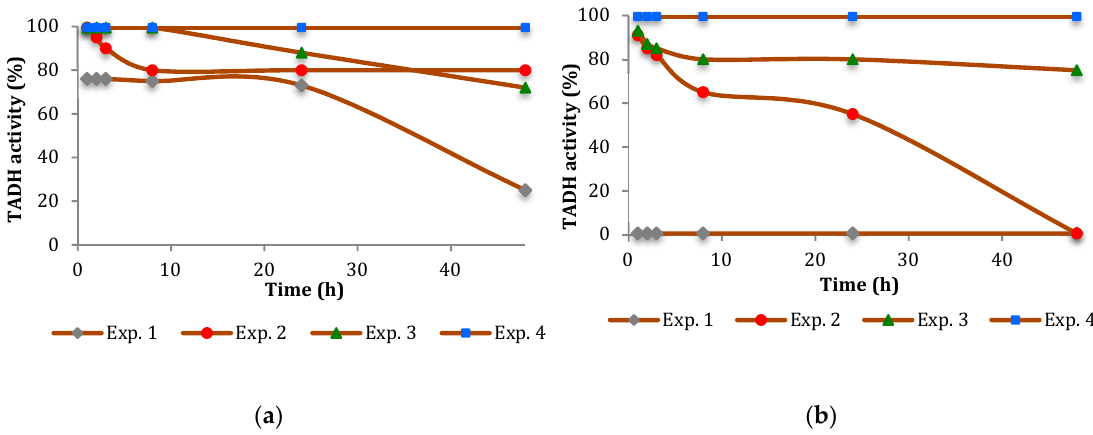
Figure 3. TADH activity (%) versus incubation time (hours) in samples made by Pd NPs incubated with different TADH volumes; NPs were of two different dimensions: ( a ) 8 nm; ( b ) 14 nm. The experimental conditions were: Exp. 1, 20 μ L of Pd NPs solution and 50 μ L of TADH; Exp. 2, 20 μ L of Pd NPs and 100 μ L of TADH; Exp. 3, 20 μ L of Pd NPs solution and 800 μ L of TADH; Exp. 4, 20 μ L of Pd NPs and 3 mL of TADH (see experimental).